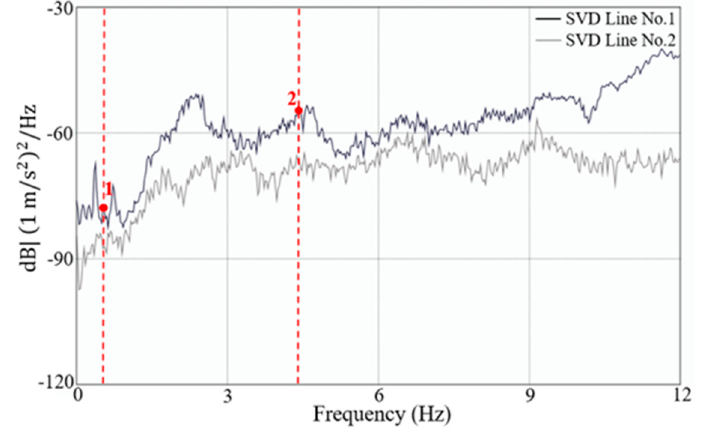
Figure 19. EFDD method: average normalised singular values of the spectral density matrices regarding Intercity comfort seat.